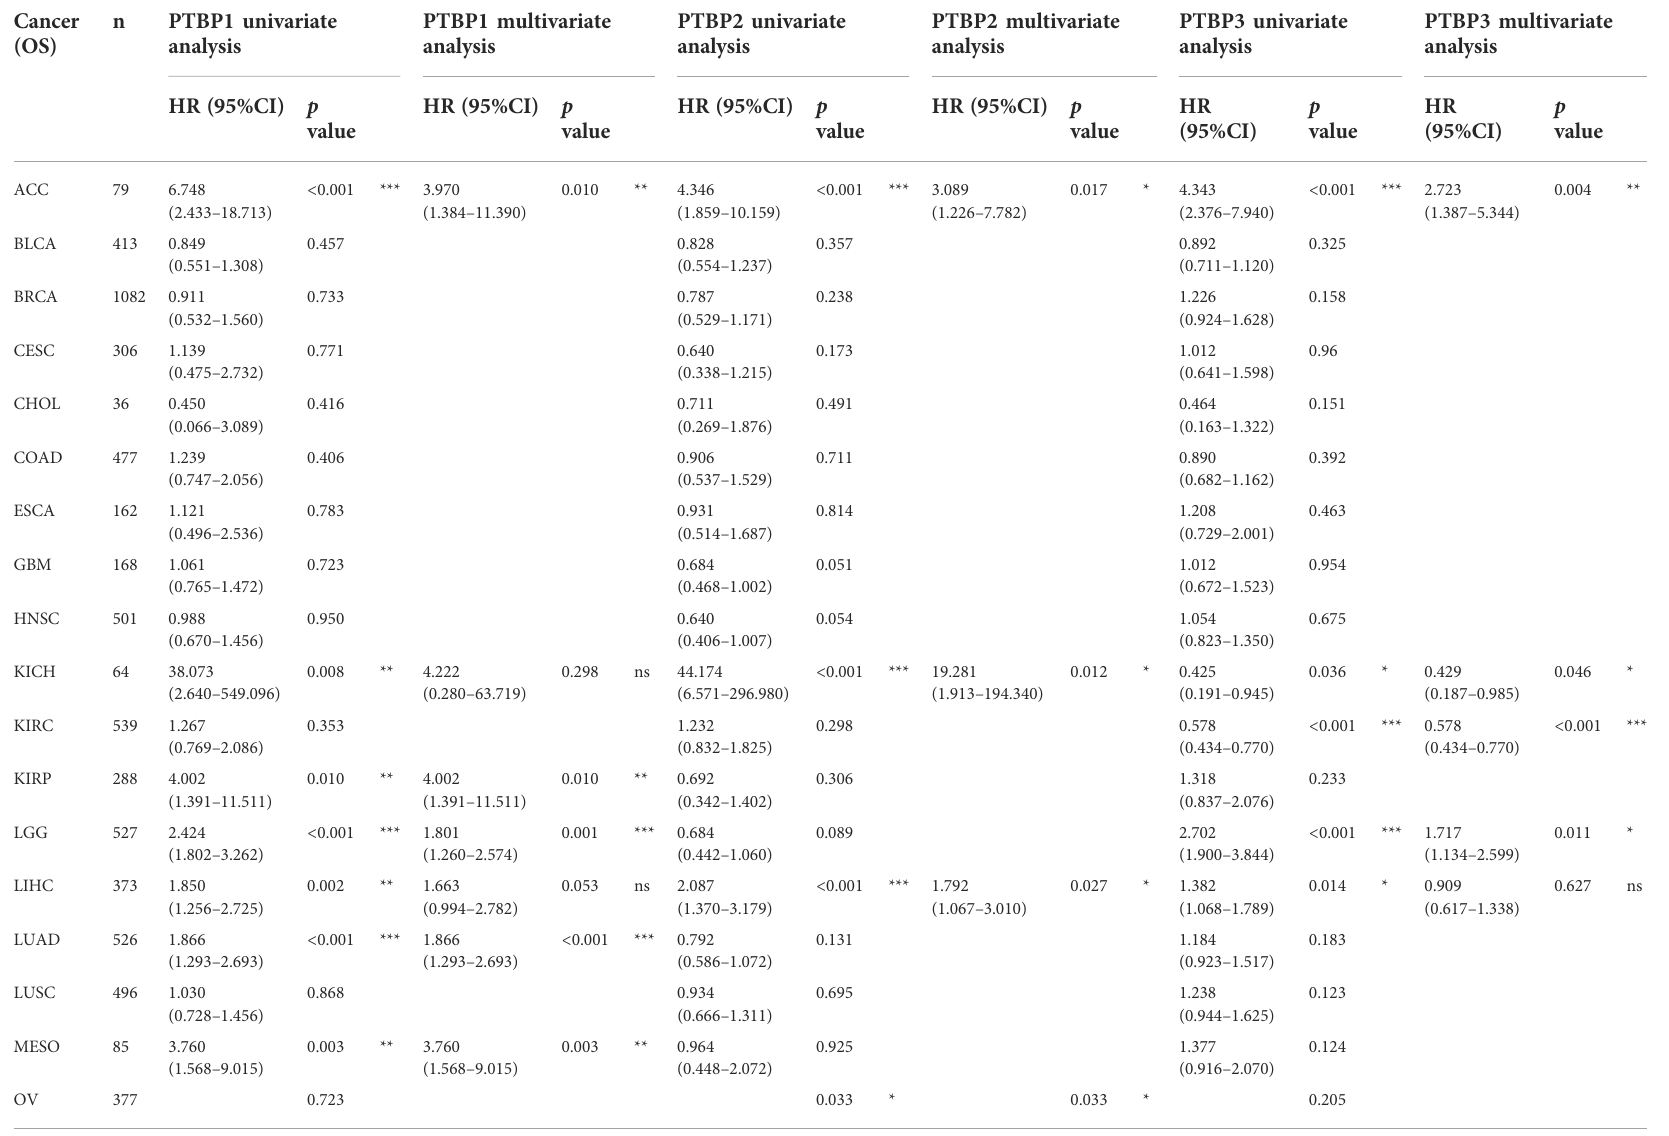
TABLE 1 Univariate and multivariate Cox regression analysis of PTBP expressions and overall survival in pan-cancer. Cancer